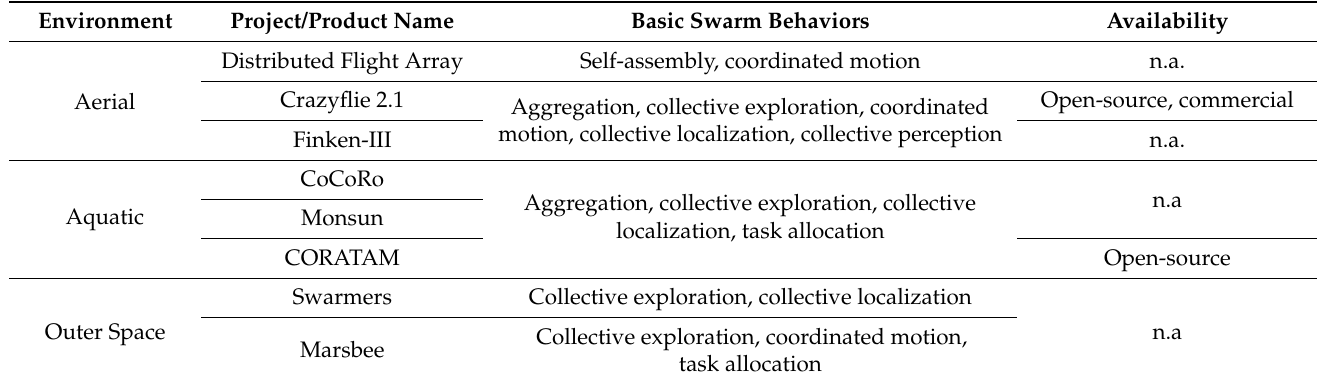
Table 3. The link between different swarm behaviors, application and adoption, and environment